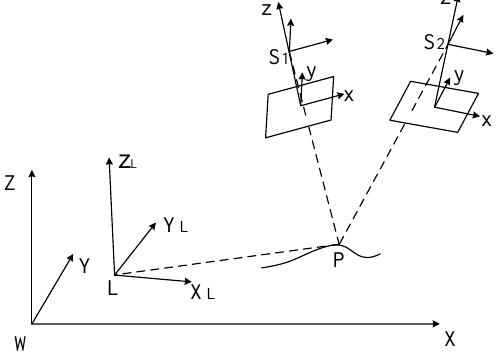
Figure 2. The definition of coordinate system.